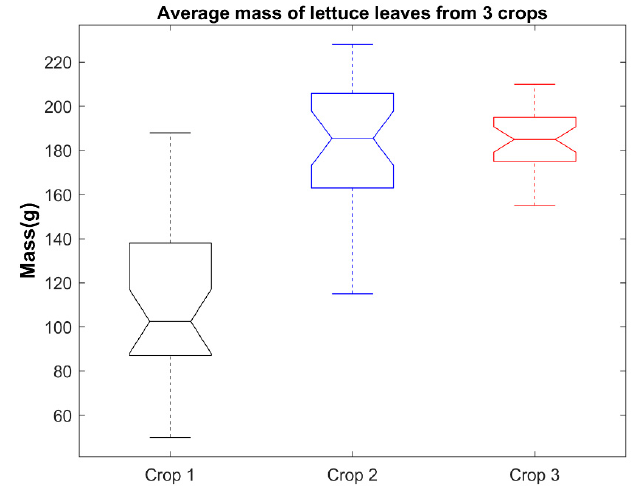
Figure 10. Average leaf fresh mass for three crops. Table 4. Average fresh mass of lettuce leaves from 3 crops. “a” means that there is no significant difference between fresh mass for crops 2 and 3.